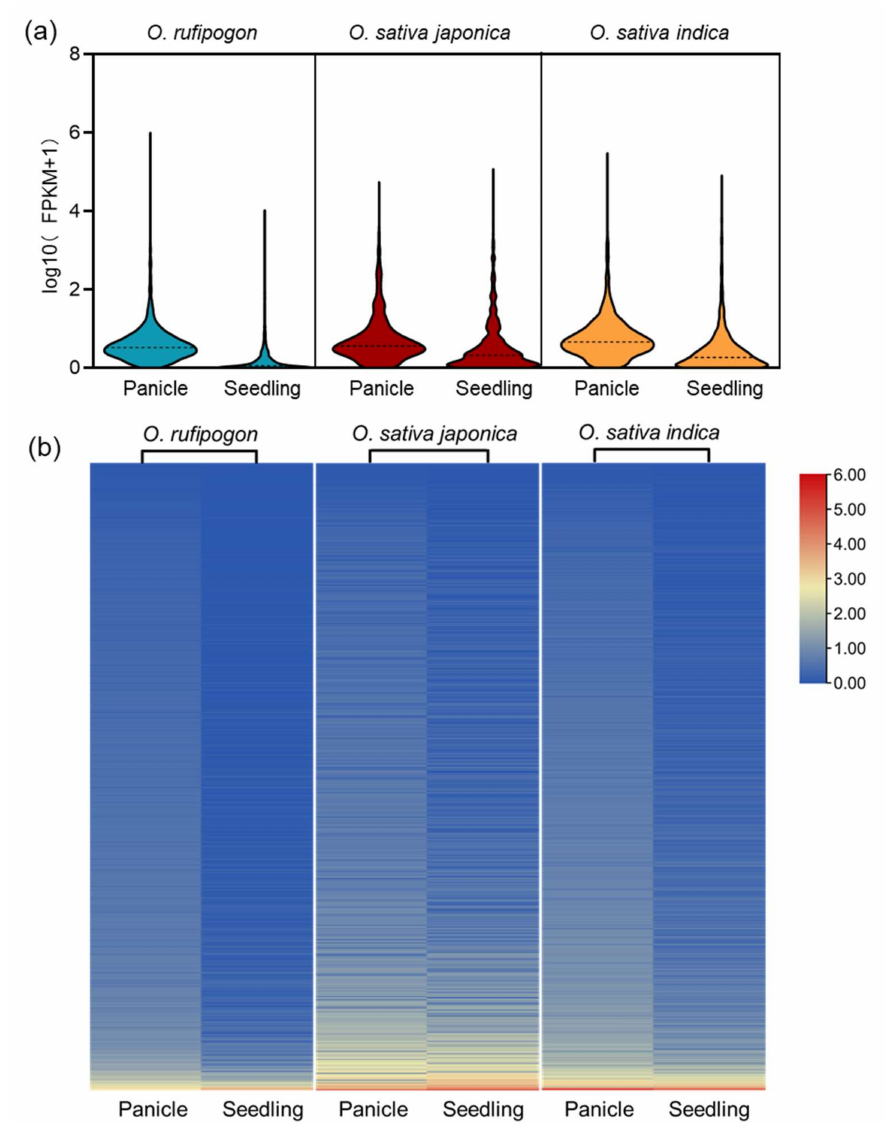
Figure 3. Expression analysis of lncRNAs from wild and cultivated rice. ( a ) The FPKM distribution of lncRNAs in panicle and seedling of wild and cultivated rice. ( b ) Heatmap of differentially expressed lncRNAs in panicle and seedling of wild and cultivated rice. All expression levels are normalized and displayed as log10(FPKM+1). The color from blue to red represents lowest to highest lncRNA